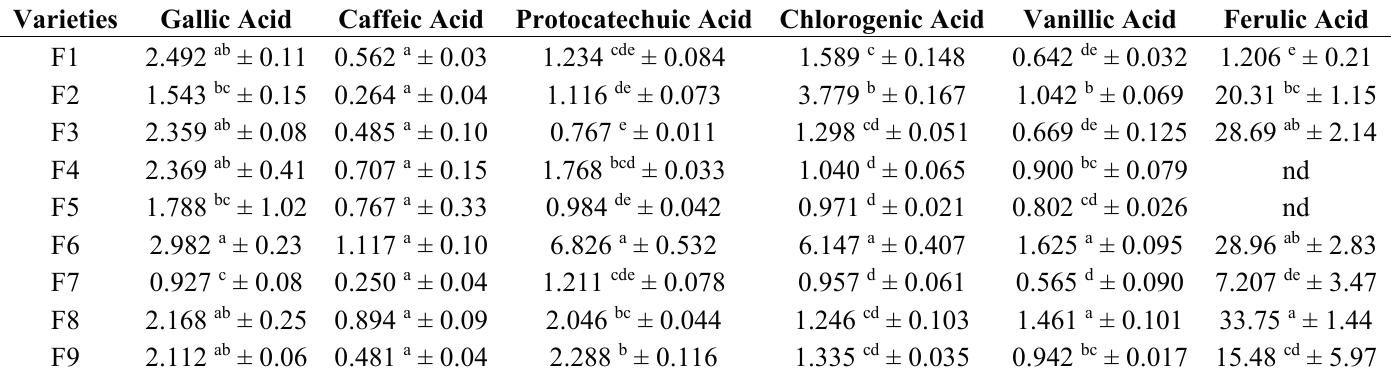
Table 3. Phenolic acids content (mg/100 g FW) in the pulp samples of mango cultivars.